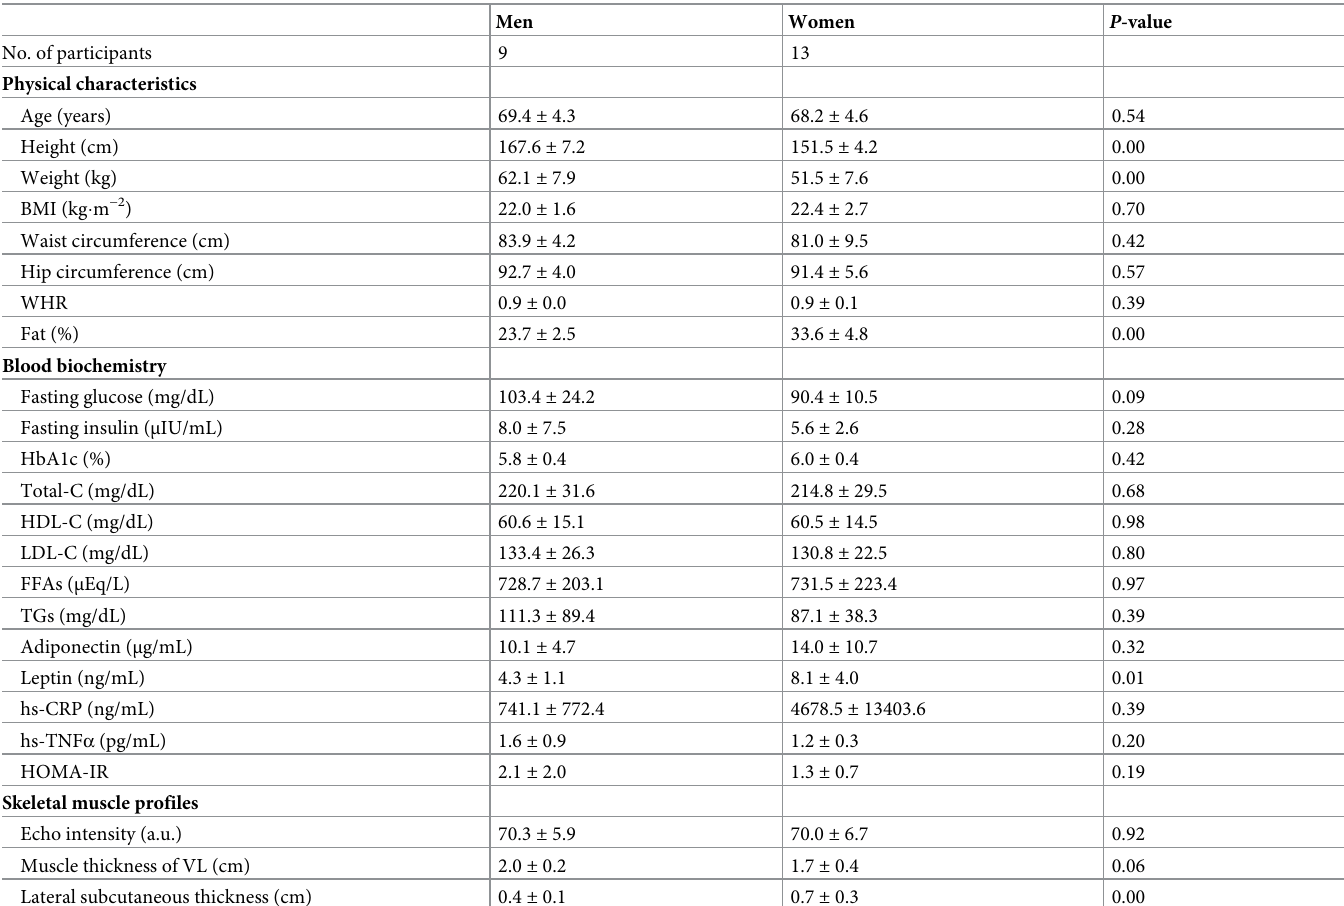
Table 1. Participant